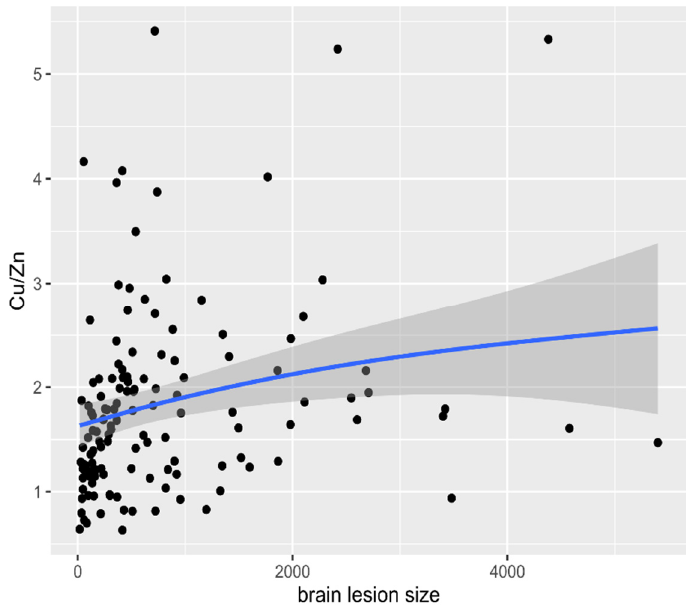
Figure 2. Correlation between brain lesion size in neuroimaging (head CT/MRI) with Cu/Zn molar ratio levels in patients with acute ischemic stroke (AIS). Abbreviations: Cu, Copper. Zn, Zinc. CT, Computered Tomography. MRI, Magnetic Resonance Imaging.